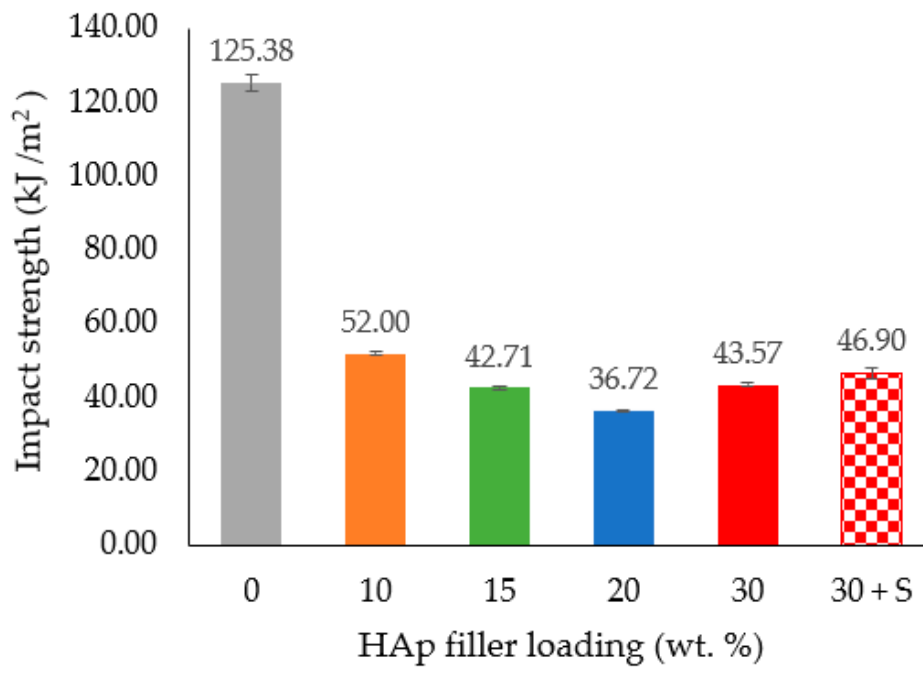
Figure 8. Effect of HAp filler on the impact strength of the HDPE/HAp composites.